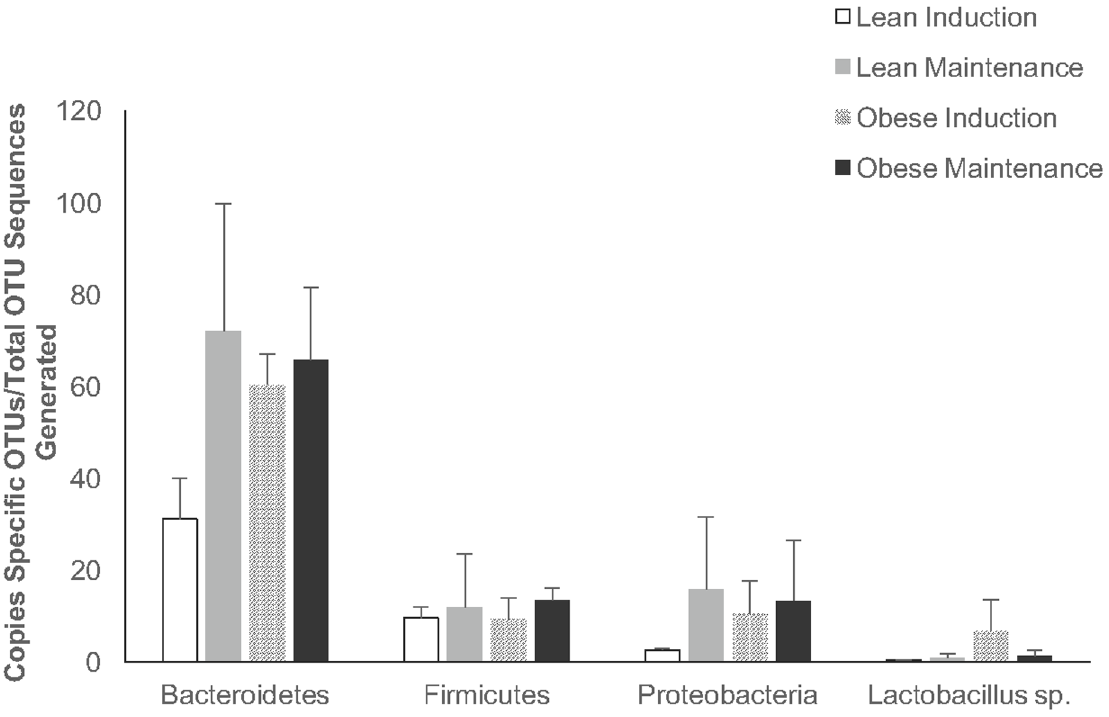
Fig 6. Relative abundance of prominent phyla and Lactobaciullus genus in vaginal swabs and cervicalflushes of both treatment groups during induction and maintenance phases. Data are shown as least squaresmean ± SEM.